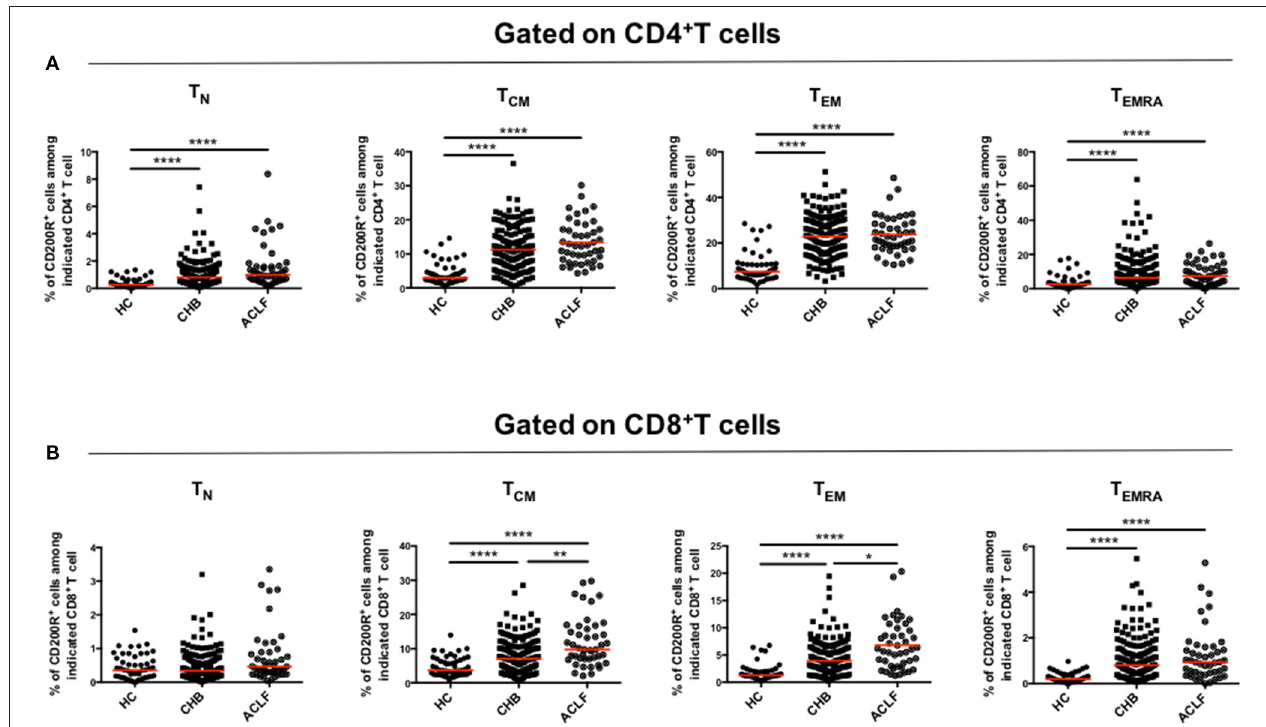
FIGURE 3 | CD200R is significantly upregulated on T CM and T EM cells in patients with ACLF. Scatter dot plots of CD200R expression in each group among four subsets (T N , T CM , T EM , and T EMRA ) gated on CD4 + T cells (A) and CD8 + T cells (B) . A one-way ANOVA or Kruskal–Wallis test was used to analyze statistical differences. ** p < 0.01, **** p < 0.0001.